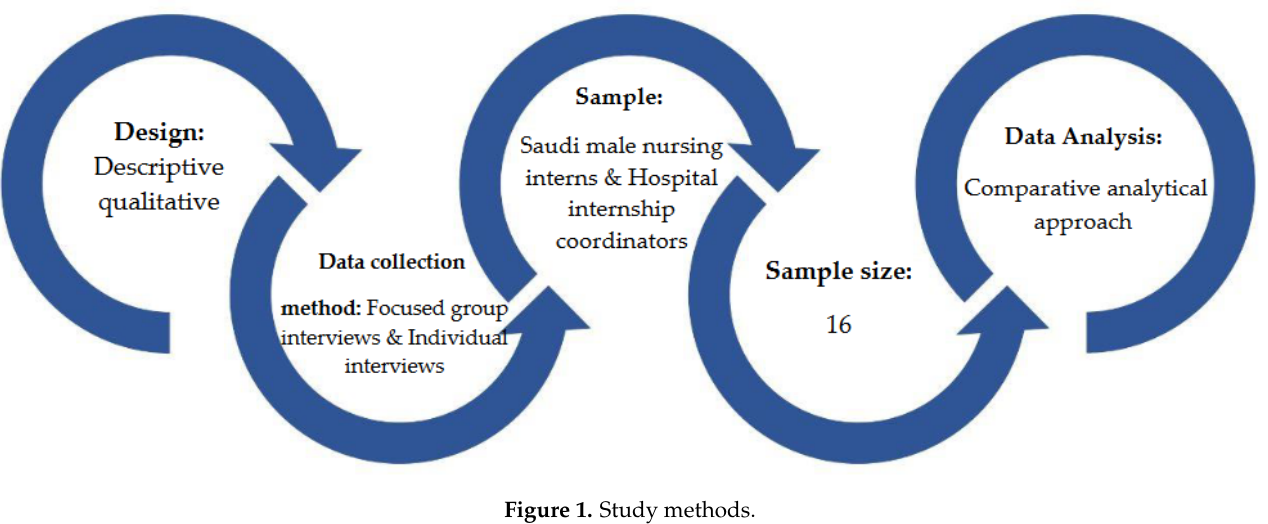
Figure 1. Study Figure 1. Study methods.